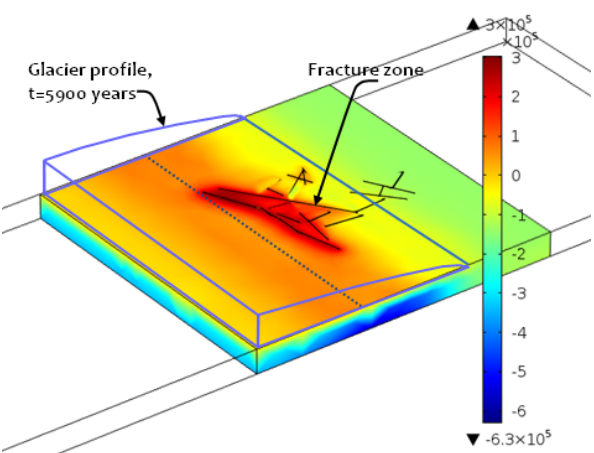
Figure 18. Distribution of the mean effective stress [Pa] within the intact part of the rock mass with fracture zones at time 5900 years. The rock is subjected to spatially non-uniform fluid pressure, com- pressive stress state and temperature change.